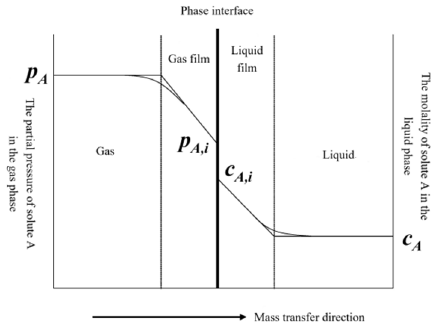
Figure 1. Schematic diagram of two–film theory.